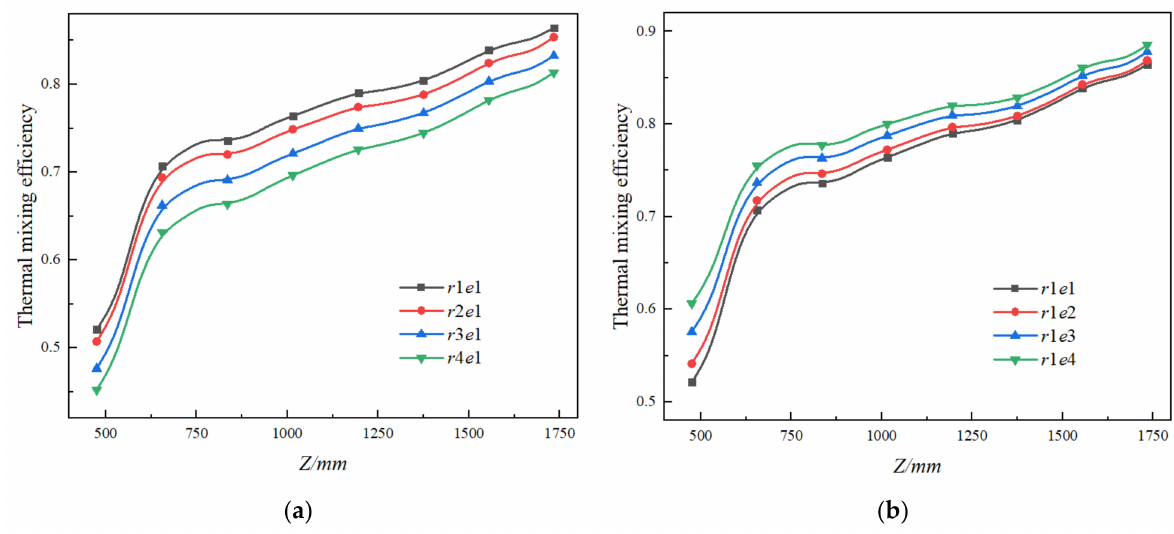
Figure 13. Thermal mixing efficiency along the flow path under cases with different cooling flow path structure parameters: ( a ) heat shield inlet height r ; ( b ) afterburner annulus height e